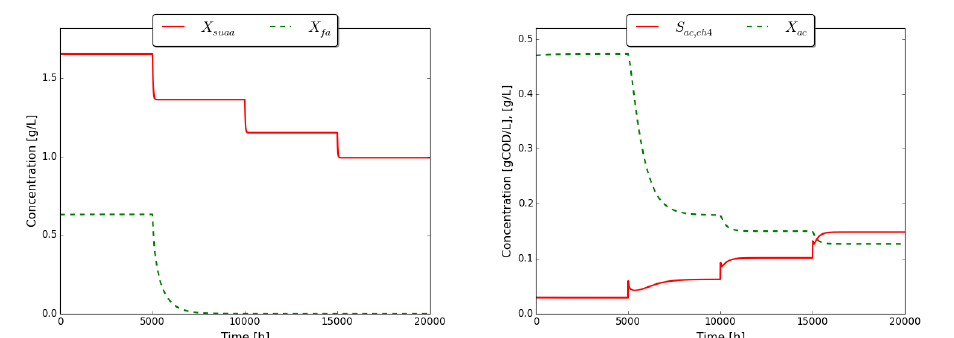
Figure 8. Dynamic behavior of the model solutions with variable D 1 from Table 3.